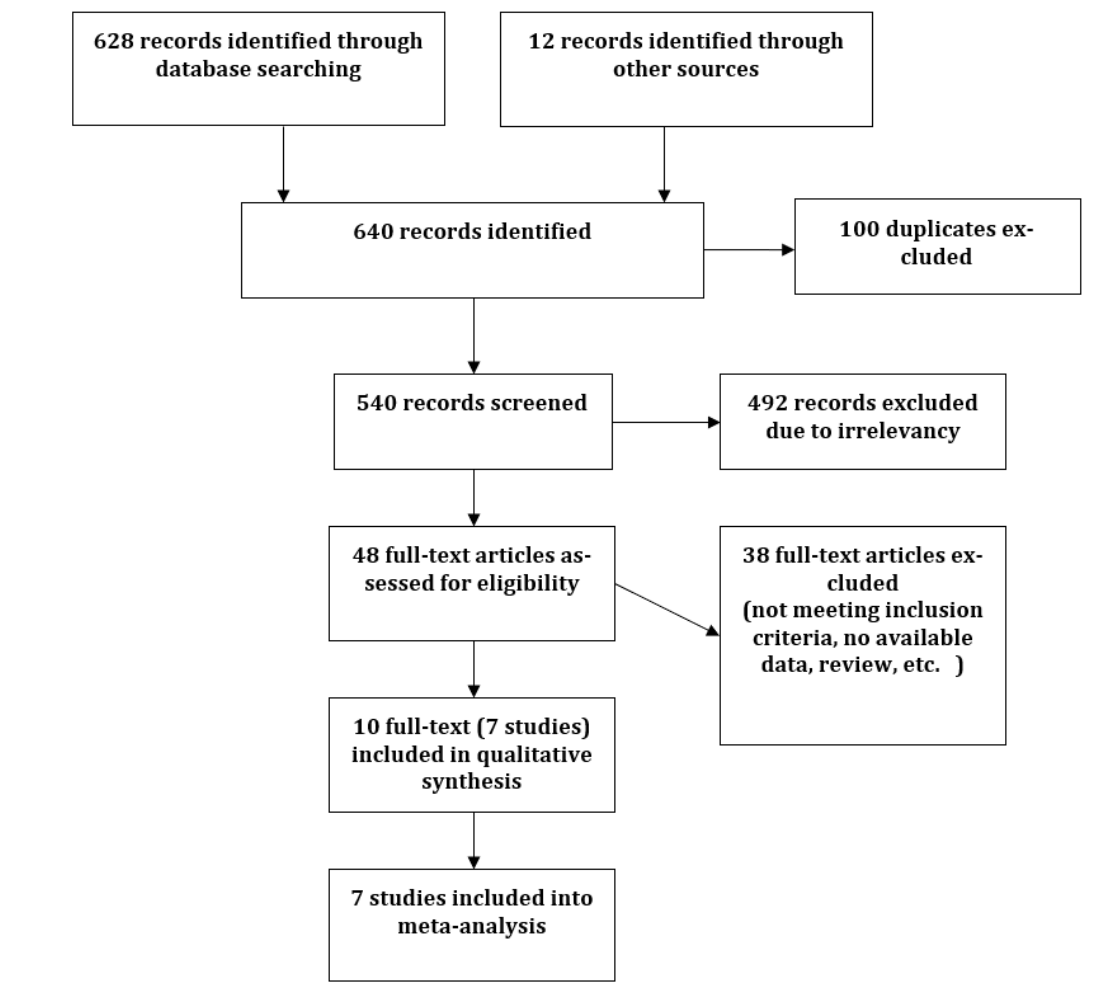
Figure A1. Prisma flow diagram.